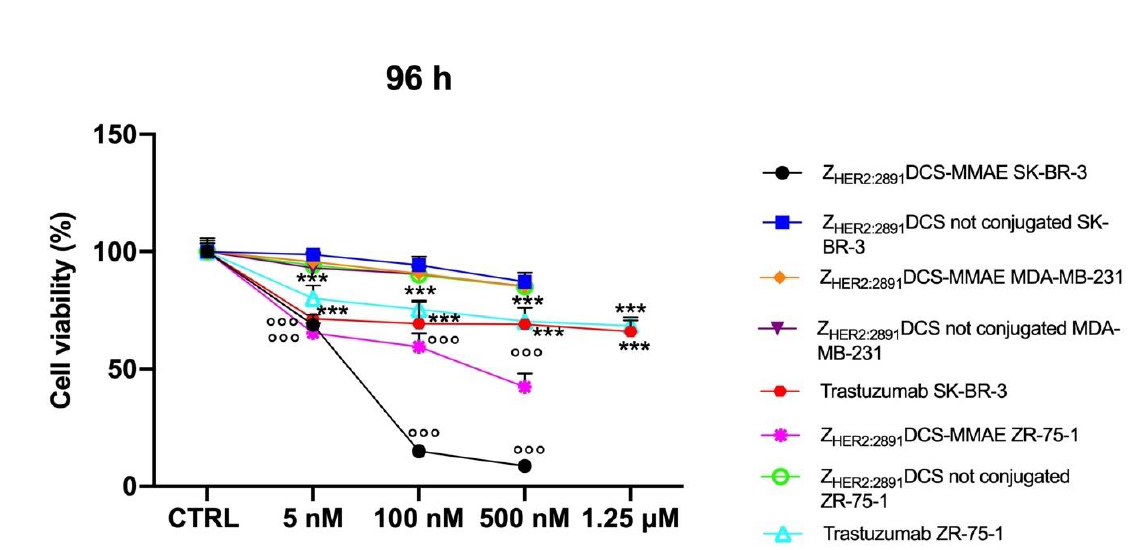
Figure 4. In vitro cell viability assay. SK-BR-3, ZR-75-1 and MDA-MB-231 cells were treated with increasing concentrations (from 5 to 500 nM) of Z HER2:2891 DCS-MMAE and not conjugated and with increasing concentrations of trastuzumab (from 5 nM to 1.25 µM). The cytotoxicity was measured using an MTT assay after 10 min followed by drug removal and an additional 48 h of incubation in medium alone (Panel A ) or for 48 and 96 h of continuous exposure to treatments (Panels B and C , respectively). The p -value was determined by one-way ANOVA test with Dunnett post hoc test and considered significant for p < 0.05 *, p < 0.01 **, p < 0.001 *** compared to control and p < 0.001 °°° compared to Z HER2:2891 DCS not conjugated. Data are presented as mean ± SEM.